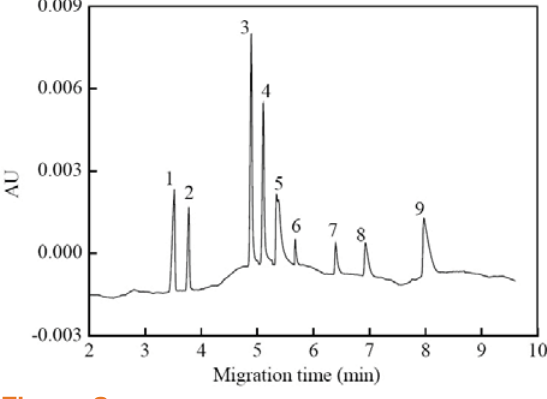
Figure 3. Separation of 9 cations (5mg L -1 ). Figure 2. Effect of D2O on the separation of inorganic cations. Injection conditions and time are the same as in Fig.1. 1. NH 4+ ; 2. K + ; 3. Na + ; 4. Ca 2+ ; 5. Mg 2+ ; 6. Mn 2+ ; 7. Zn 2+ ; 8. Co 2+ ; 9. Cu 2+ .